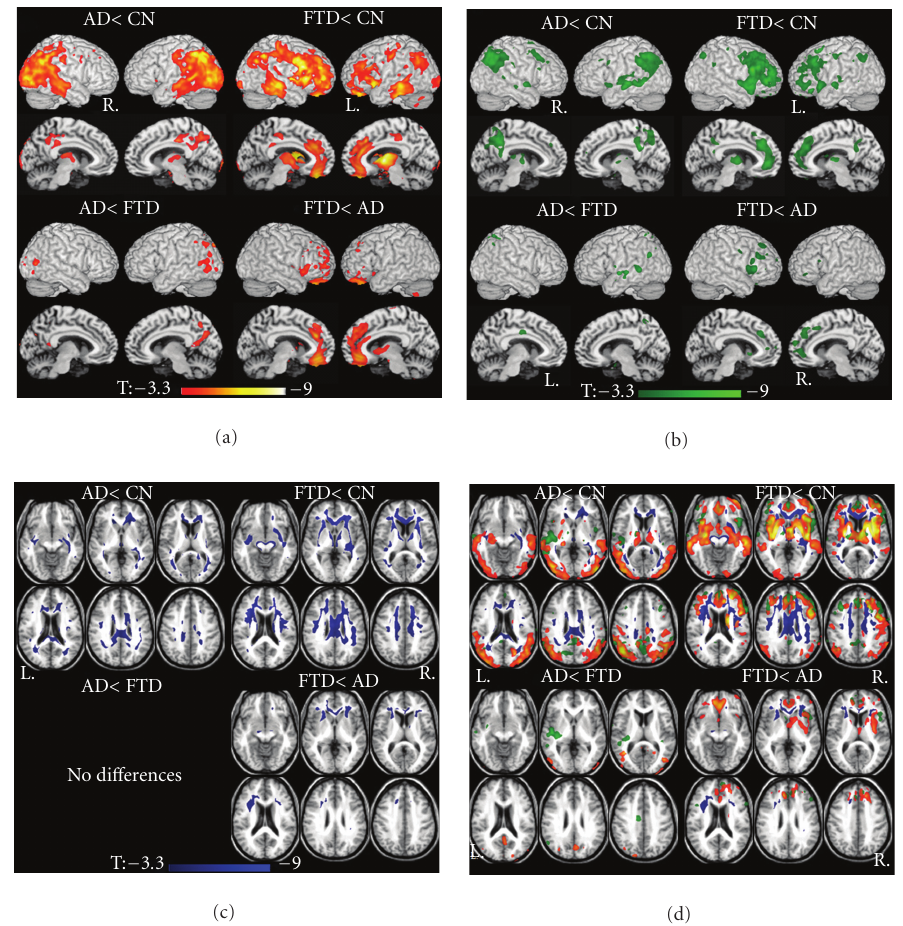
Figure 1: Significance maps of systematic brain abnormalities in FTD and AD patients relative to control subjects (AD < CN and FTD < CN ), and direct comparisons between AD and FTD (AD < FTD and FTD < AD ). (a) GM loss (warm color) and (b) GM hypoperfusion (green color) overlaid on a surface rendered brain template. (c) Reduced WM FA (blue color) in AD or FTD overlaid on an axial brain template. (d) Overlay of the abnormal distributions together. The significant threshold was P uncorrected < . 001 for all voxelwise tests. Color scales indicated ranges of significance (T-scores) upon the P